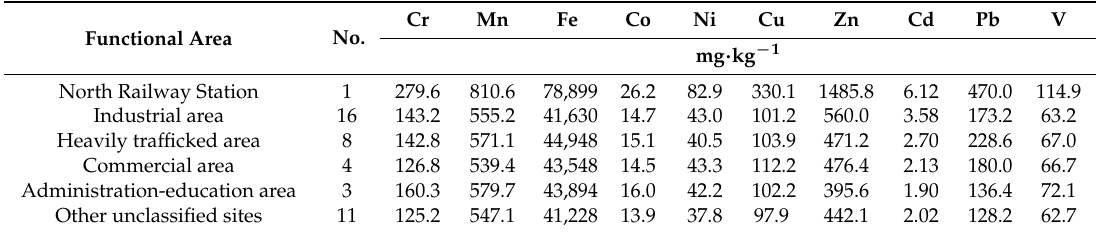
Table 2. A comparison of heavy metal concentrations (mg · kg − 1 ) in settled dust from different urban functional areas in